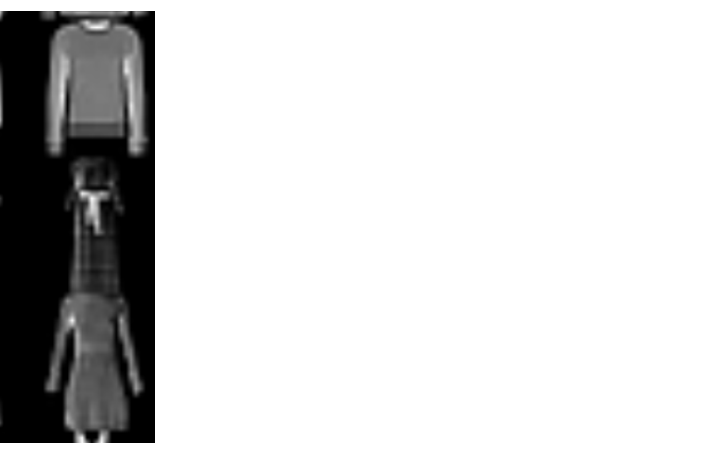
Figure 5. Fashion-MNIST sample showing examples of data such as: boots, bags, jumpers, and trousers